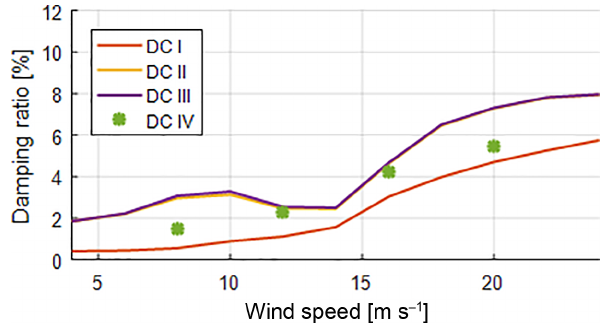
Figure 19. Damping ratio over wind speed for all decoupled mod- els optimized for variance of tower top